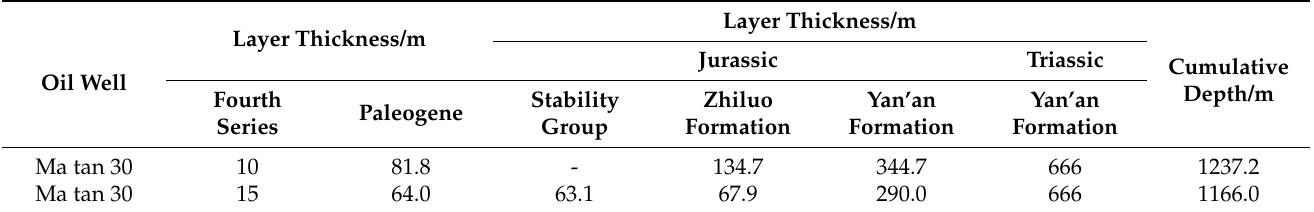
Table 4. Abandoned oil wells pass through the formation and statistics of